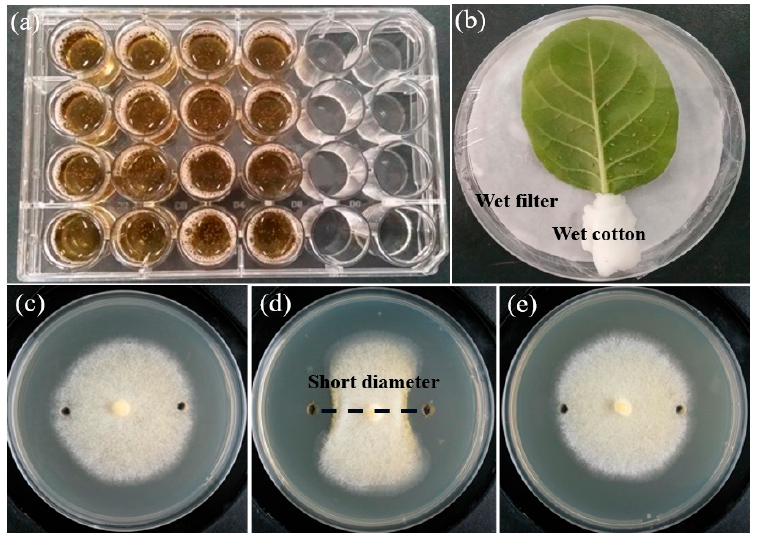
Figure 1. The methods adopted to test insecticidal and antifungal activities; 24-well cell culture plate for testing toxicity for brine shrimp ( a ); the aphids treated with an impregnation method in a Petri dish with moisturizing treatment ( b ); the modified micro-atmosphere method to check antifungal activity, treated with DMSO ( c ); extract crudes (( d ), a case of AS67); and Prochloraz ( e